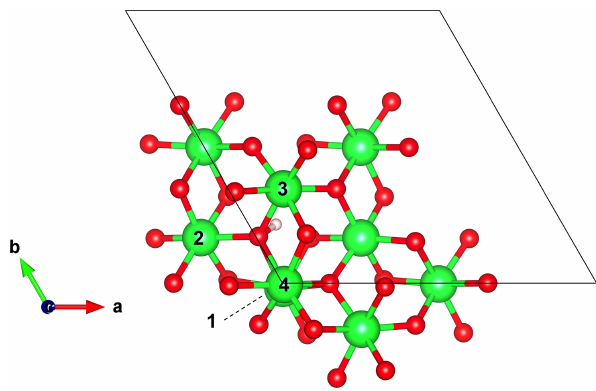
Figure 3. Structure of the interstitial proton model ( ( 1H + ) i ) viewed along the [001] direction. Models of Mg-bearing defects (Table 1) have been obtained by substituting Mg 2 + cations for Al 3 + in the nearby Al sites labeled from 1 to 4. Note the canting of the OH group with respect to the (001)